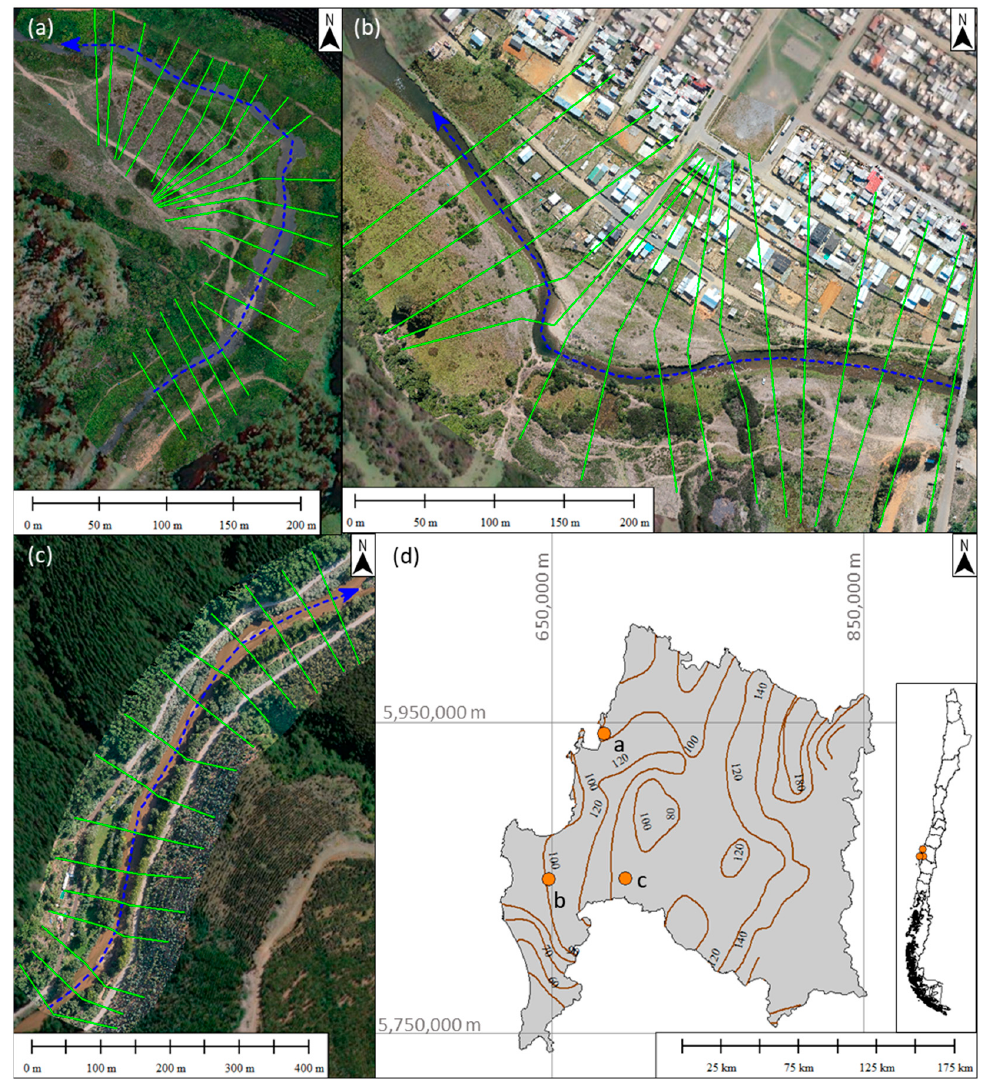
Figure 1. Orthophoto of the ( a ) Bellavista (Lat/Lon: 36°38 ′ 51 ″ S, 72°56 ′ 41 ″ W), ( b ) Curanilahue (Lat/Lon: 37°29 ′ 35 ″ S, 73°19 ′ 21 ″ W), and ( c ) Nicodahue (Lat/Lon: 37°29 ′ 13 ″ S, 72°46 ′ 25 ″ W) rivers and ( d ) their locations in Chile, with a map of rainfall isohyets in mm. The green lines indicate the cross sections of the modeling domain and the blue lines indicate the flow directions of the rivers. Coordinates UTM 18S (WGS 84).